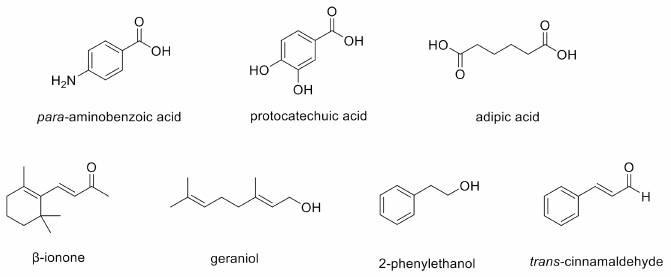
Figure 1. Target industrial platform chemicals for ISPR in the present